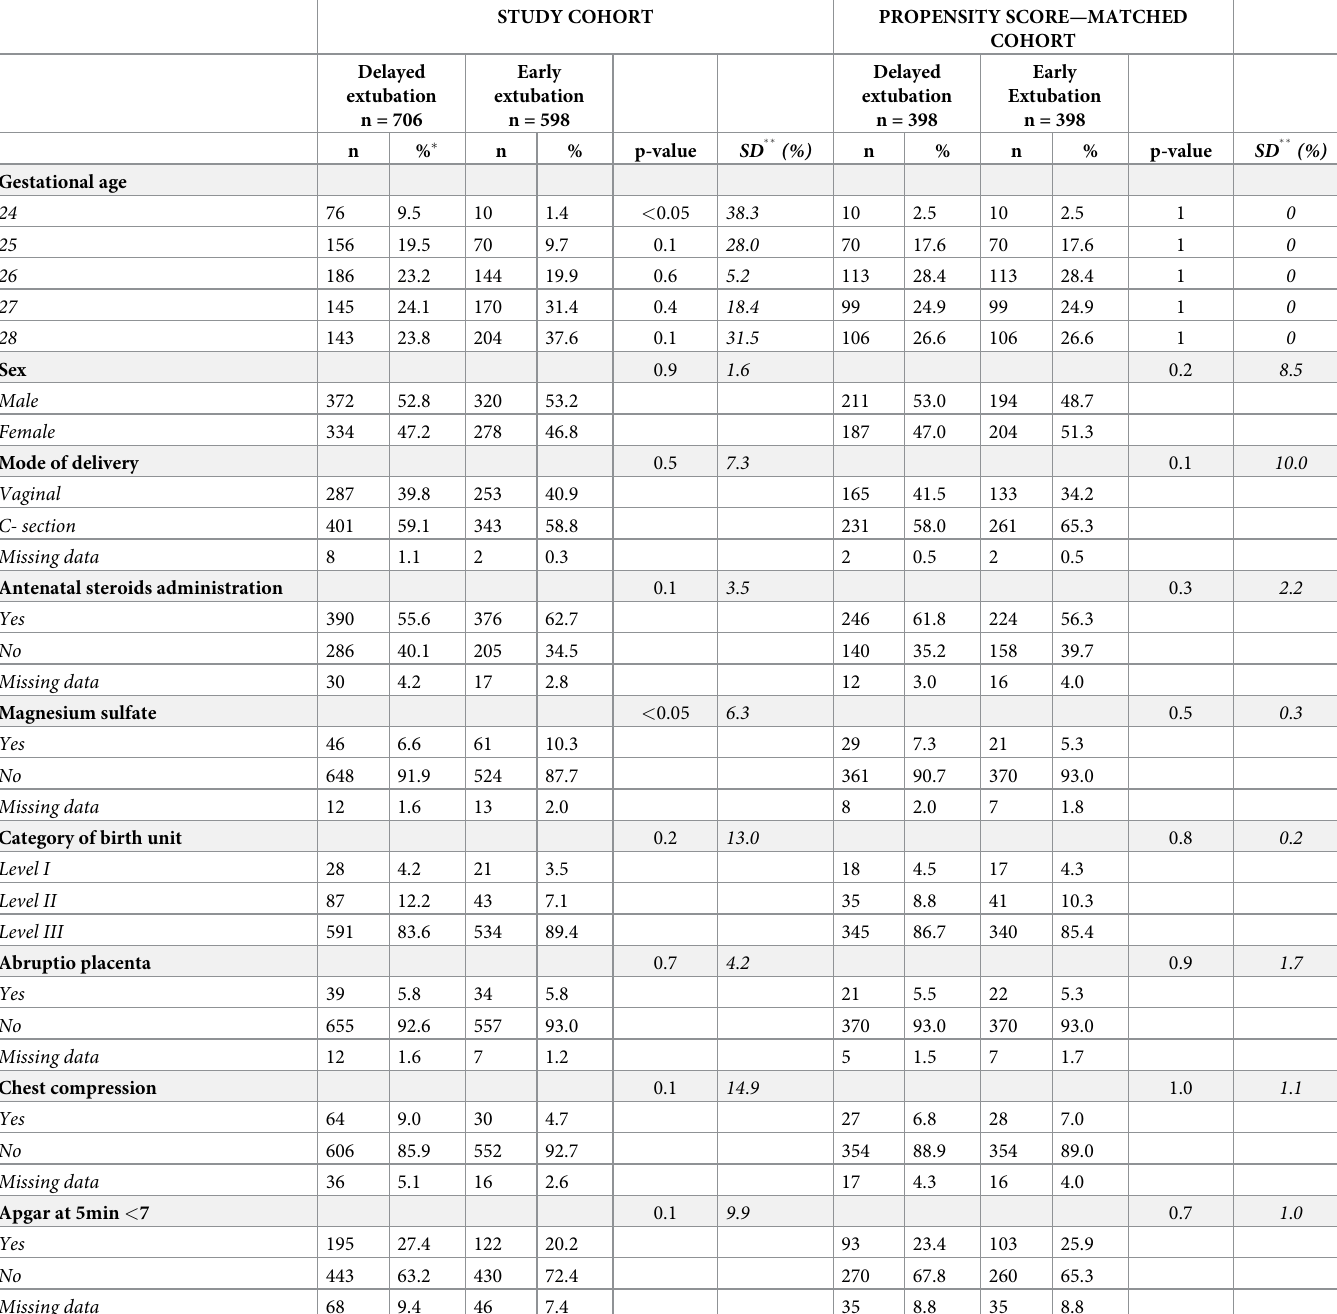
Table 1. Baseline variables according DE and EE within study cohort/ Propensity score-matched